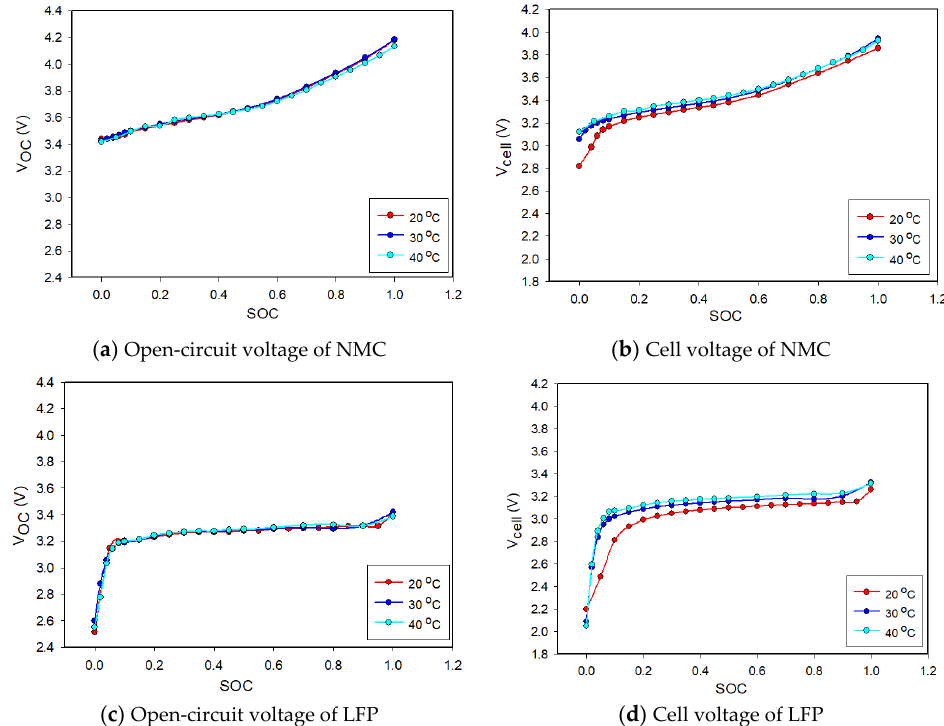
Figure 5. Electrical characteristics of the cylindrical cells with respect to SOC at various temperatures: ( a ) open-circuit voltage of NMC, ( b ) cell voltage of NMC, ( c ) open-circuit voltage of LFP, and ( d ) cell voltage of